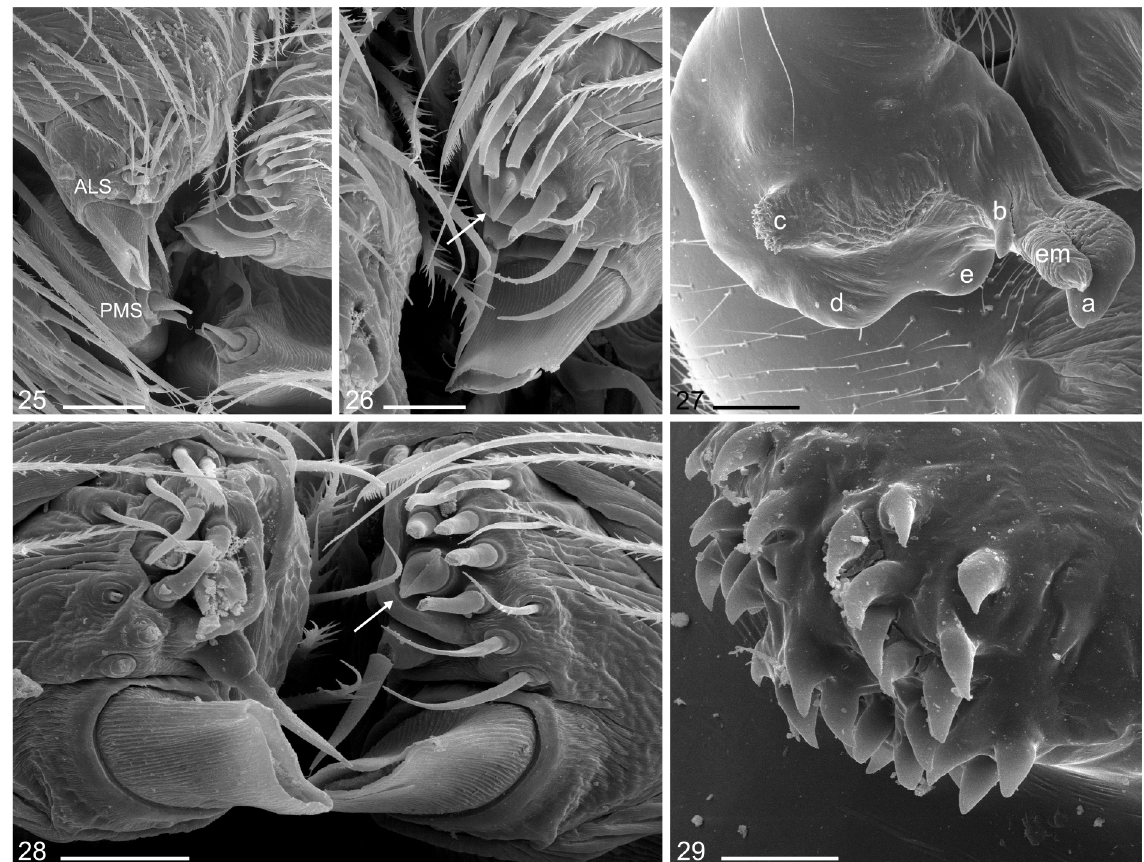
Figs 25–29. Artema atlanta Walckenaer, 1837, ZFMK Gui 82 and ZFMK Gui 111. 25–26 , 28 . Male ALS and PMS (arrows: one of the six small cylindrically-shaped spigots wider than others). 27 . Male left bulb, prolateral-distal view. 29 . Small teeth prolaterally on round end of process c. Scale lines: 25 = 0.06 mm; 26, 29 = 0.03 mm; 27 = 0.2 mm; 28 = 0.04